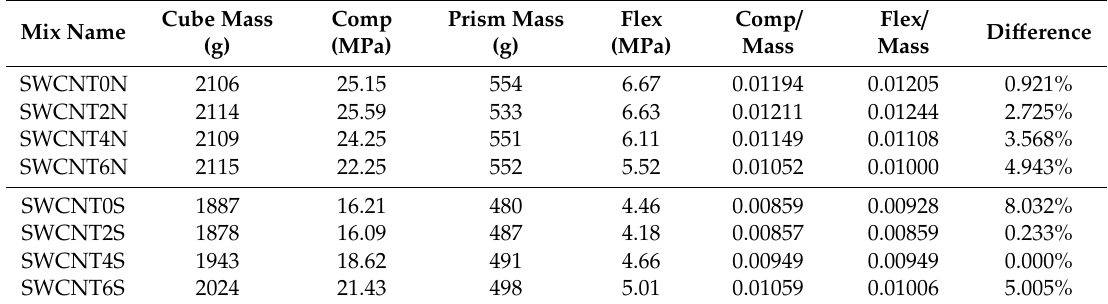
Table 14. Compressive (flexural) strength / mass ratio of cubes (prisms) at seven days of